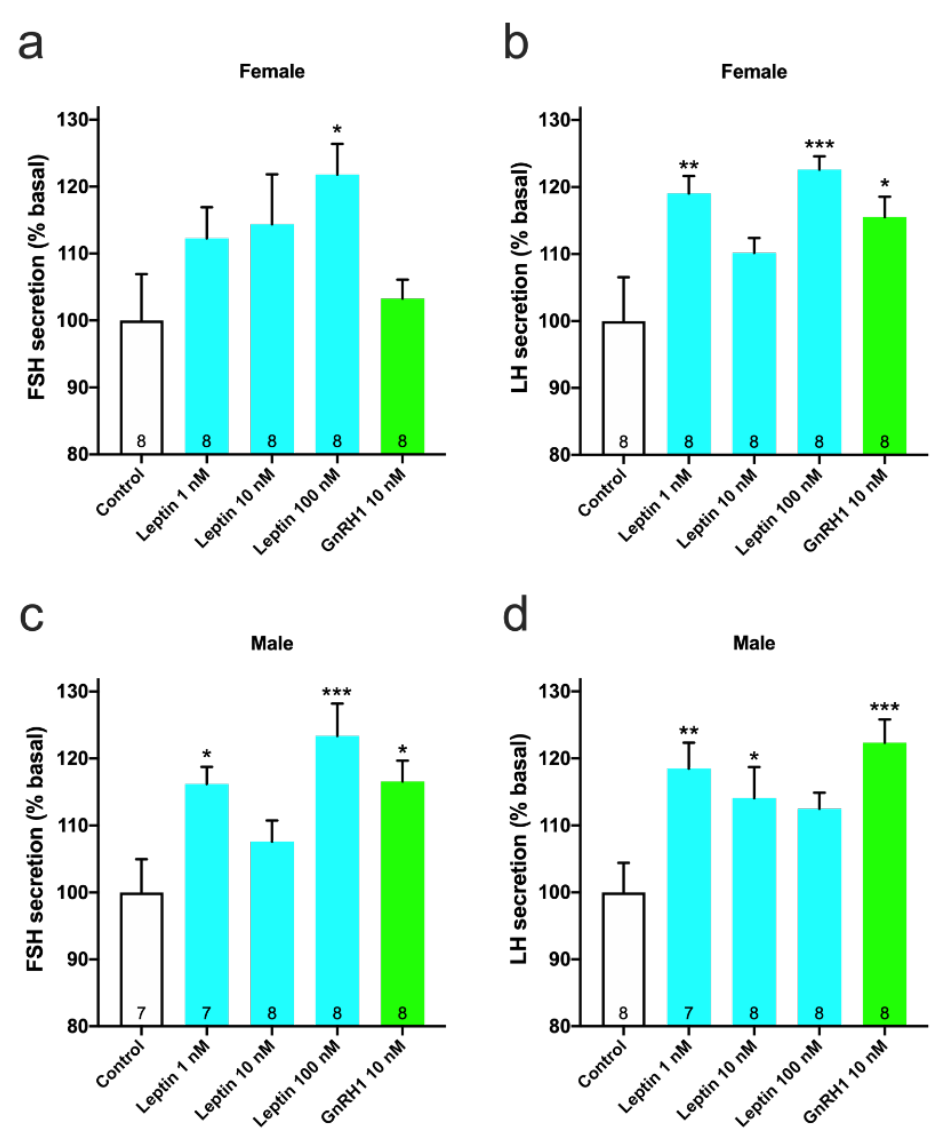
Figure 3. In vitro effect of leptin on GTH secretion from primary pituitary cells. Cells were treated with graded concentrations of leptin for 1 h. ( a ) FSH and ( b ) LH secretion in females and ( c ) FSH and ( d ) LH secretion in males. Data represented the mean ± SEM and were analyzed by one-way ANOVA, followed by a Dunnett’s multiple comparison test (vs. control group). The number at the bottom of the column indicates the number of samples. * p < 0.05, ** p < 0.01, *** p < 0.001.